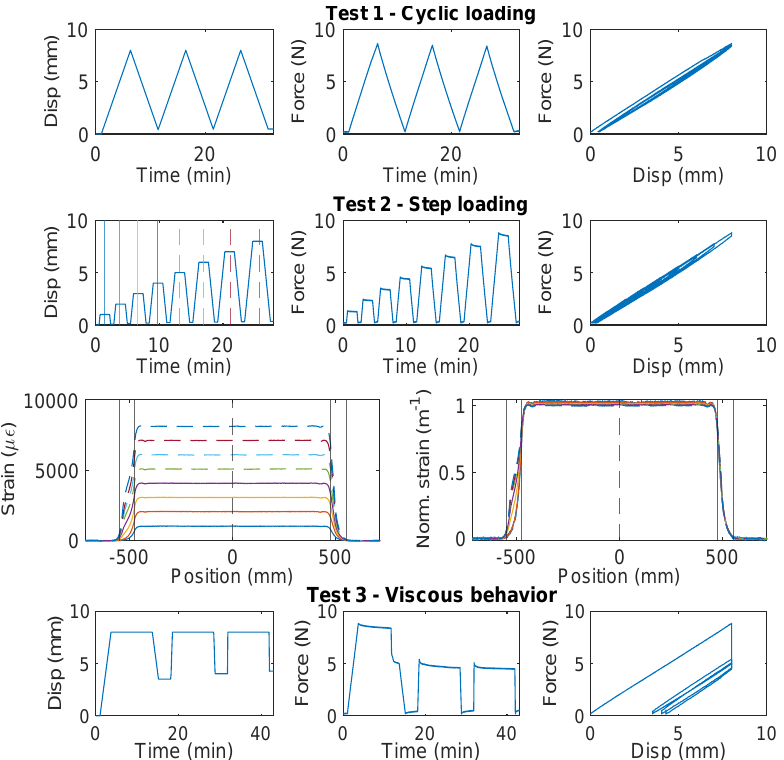
Figure 9. The loading protocol, force–displacement relation and strain distributions under increasing displacement levels (represented by different color lines) for Specimen 1 of the PVC 0.9 mm cable.